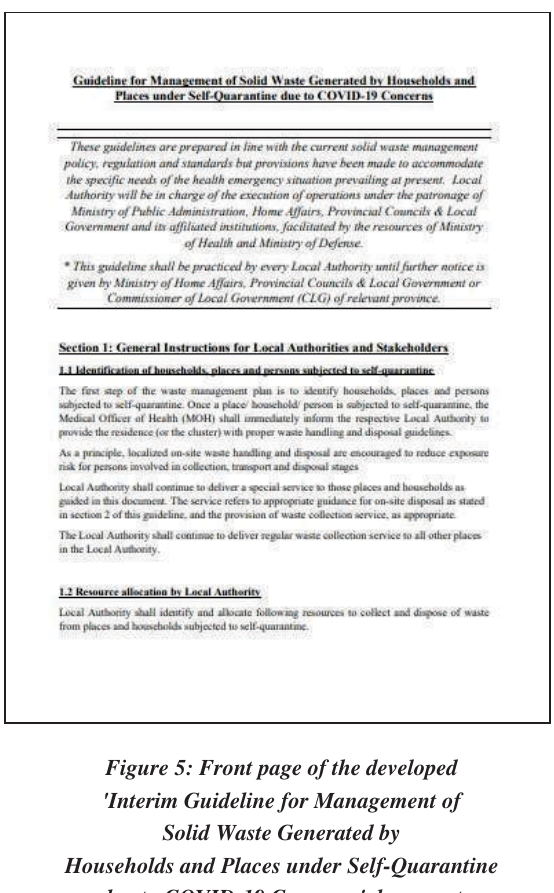
Figure 5: Front page of the developed 'Interim Guideline for Management of Solid Waste Generated by Households and Places under Self-Quarantine due to COVID-19 Concerns'